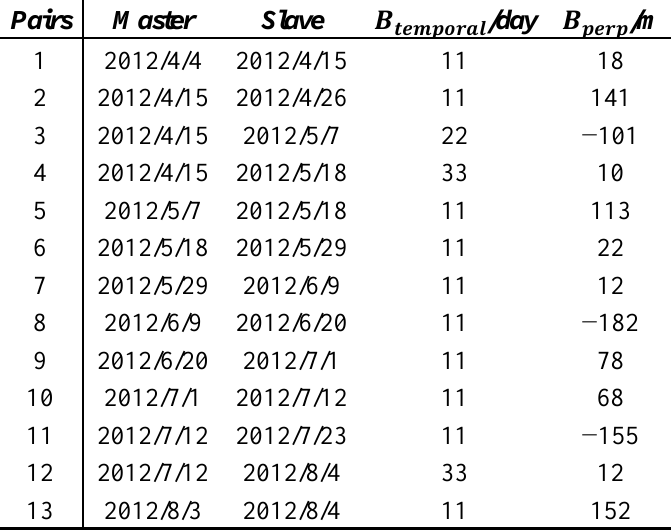
Table 6. TerraSAR-X pairs formed in this